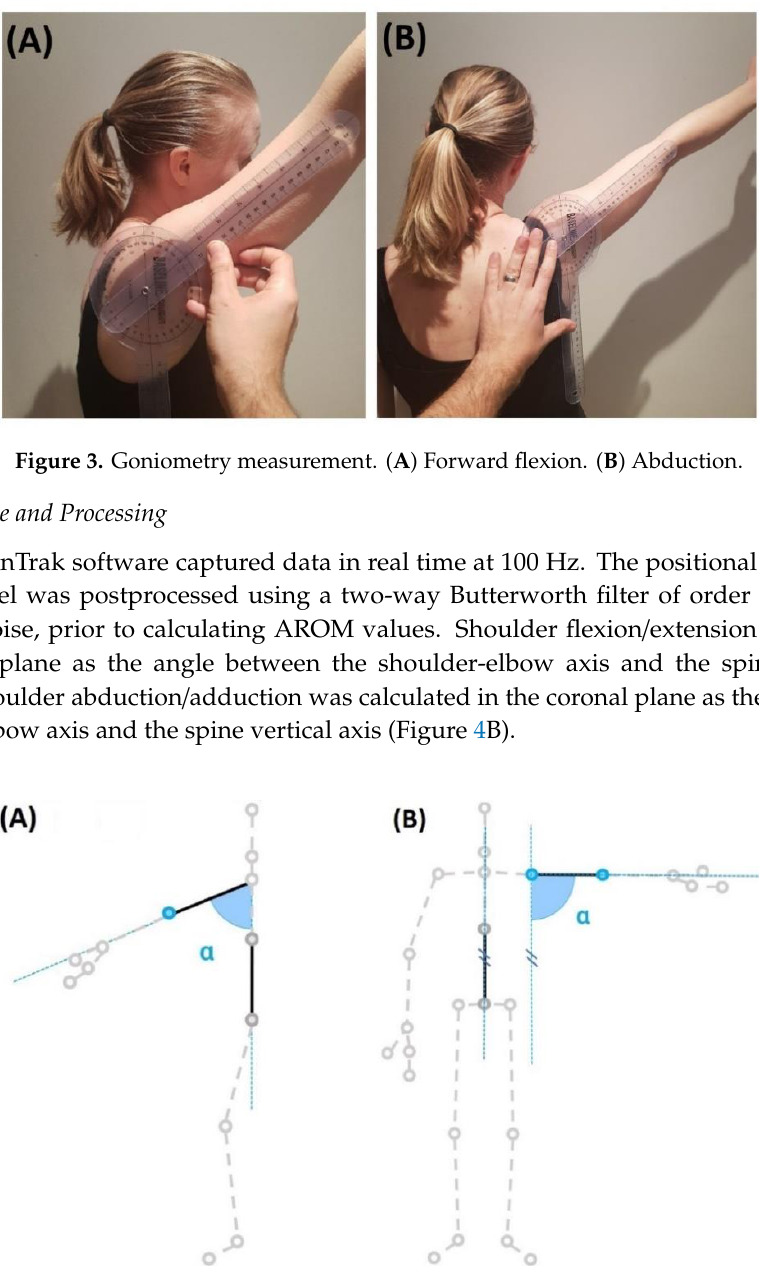
Figure 4. Shoulder joint range-of-motion (ROM) calculation with HumanTrak. ( A ) Shoulder forward flexion: angle (α) between the trunk (mid spine-spine base) and the upper limb (shoulder-elbow) in the sagittal plane. ( B ) Abduction: angle (α) between the trunk (mid spine-spine base) and the upper limb (shoulder-elbow) in the frontal plane.